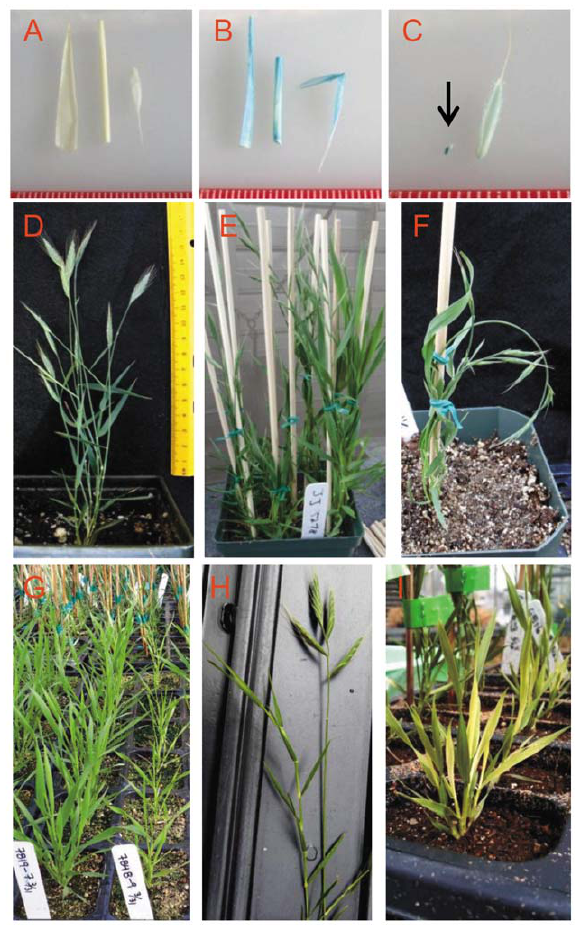
Figure 3. Phenotypes observed in the T-DNA population. A–C. GUS staining of lines created with pJJ2LBP and pJJ2LBP2 vectors. Leaf, stem and floral tissue (arranged left to right) collected from plants transformed with gene trap vectors were stained to detect GUS expression. Ruler divisions are in millimeters. A. Blue color was not detected in line JJ5896 indicating an absence of GUS expression. B. GUS expression is indicated by the blue color in all three tissue types for line JJ6405. C. For line JJ6135 expression was primarily detected in the developing embryo indicated by the black arrow. D–I. Images highlighting a selection of mutant phenotypes observed in the T- DNA population. D. Wild-type Bd21-3 plant. E. Flowering time variation illustrated by a late flowering mutant in the front right of the pot. F. Morphology variation represented by a mutant with curling stems and leaves. G. Size differences illustrated by the row of short plants on the right. H. Increased segmentation, branching and delayed flowering time (left) compared to the wild-type plant (right). I. Pigmentation mutants.